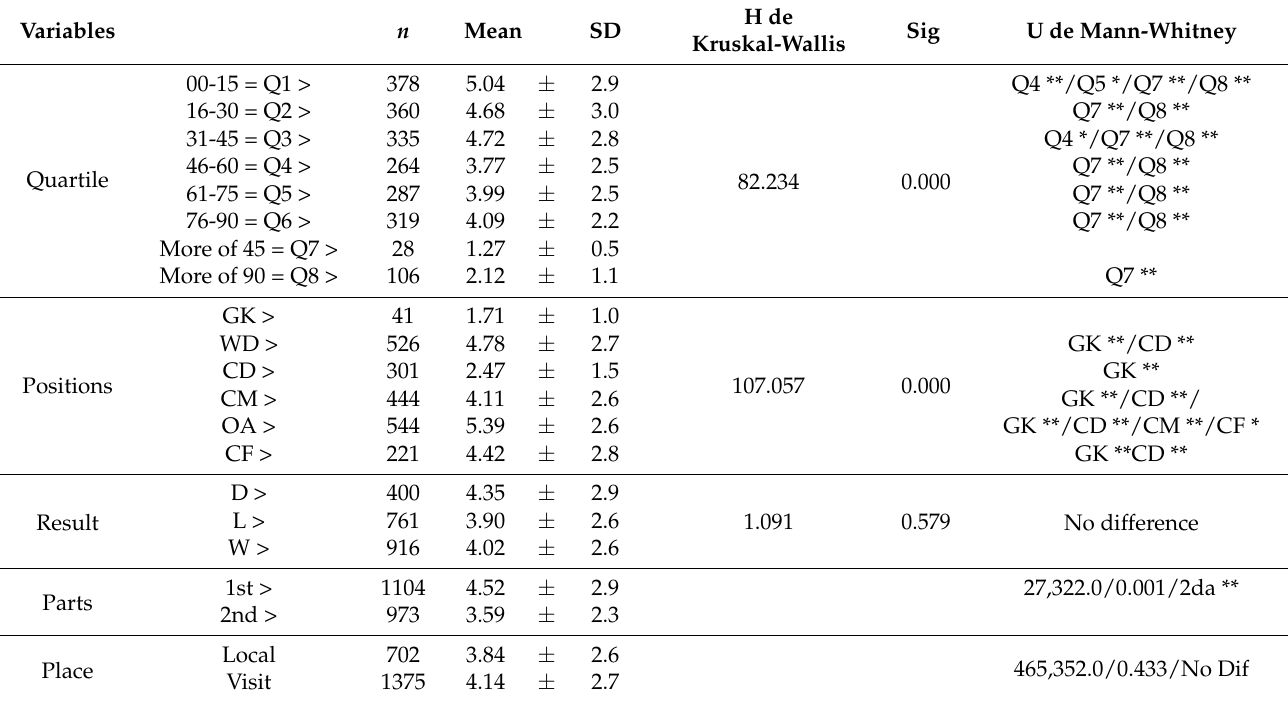
Table 7. Summary of each 15-min period of matches, playing positions, match result, first and second half and match location (Data reported as mean ±